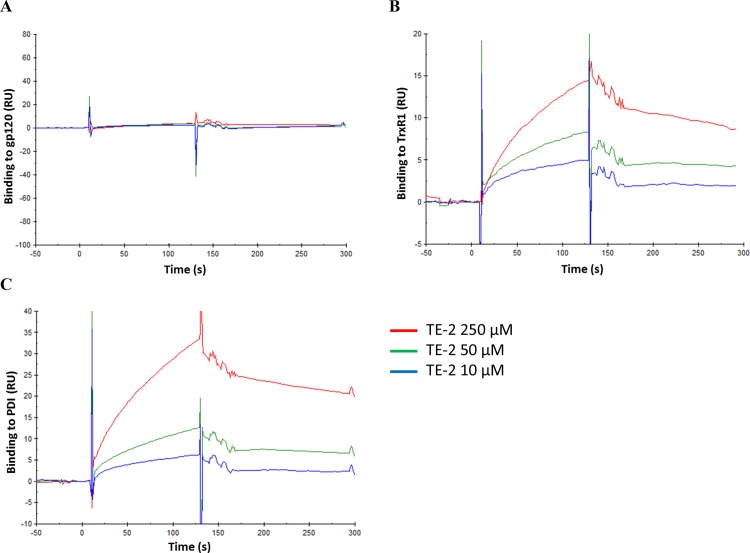
Binding of TE-2 to HIV-1 gp120, TrxR1 or PDI by SPR.The SPR technique was used to evaluate binding of 3 concentrations of TE-2 to gp120, TrxR1 and PDI, using a high density CM5 chip and a Biacore T200 instrument. The SPR sensorgrams show the binding of TE-2 to the immobilised ligand on the chip, and the subsequent dissociation (after 120 sec) of TE-2. (A) Binding of TE-2 to gp120 (B) Binding of TE-2 to TrxR1. (C) Binding of TE-2 to PDI.